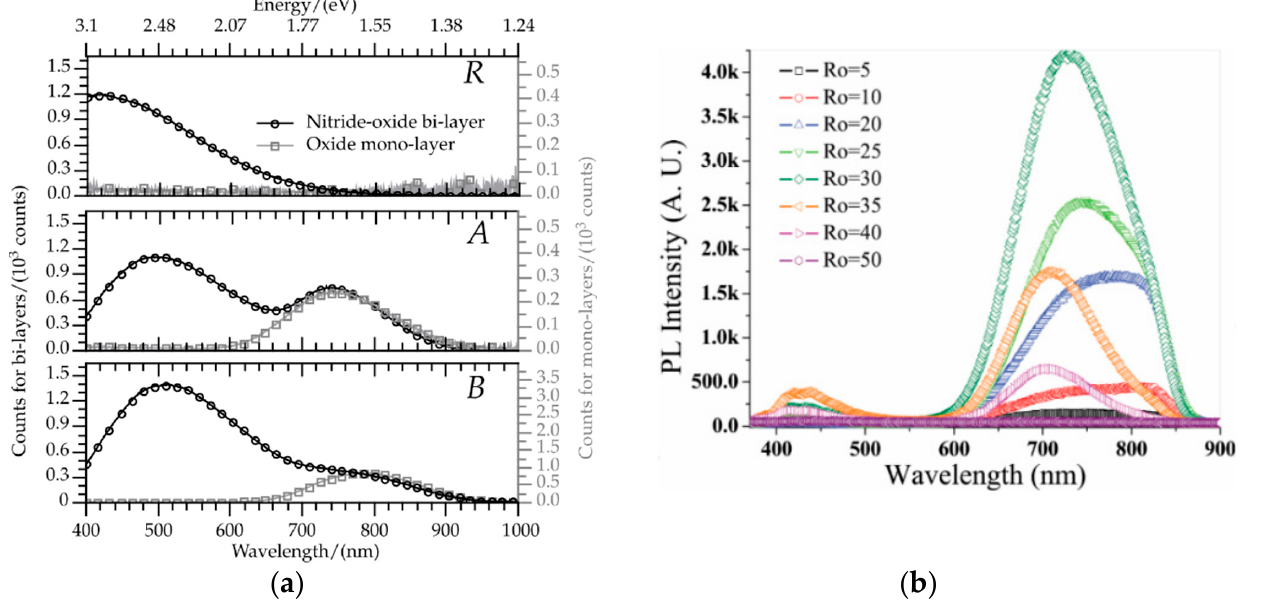
Figure 1. (a) PL spectra of II-SRO and II-SRO/Si3N4 films [38]; (b) LPCVD-SRO films with different precursors gas ratios, Figure 1. ( a ) PL spectra of II-SRO and II-SRO/Si3N4 films [38]; ( b ) LPCVD-SRO films with different precursors gas R 0 [28]. ratios, R 0